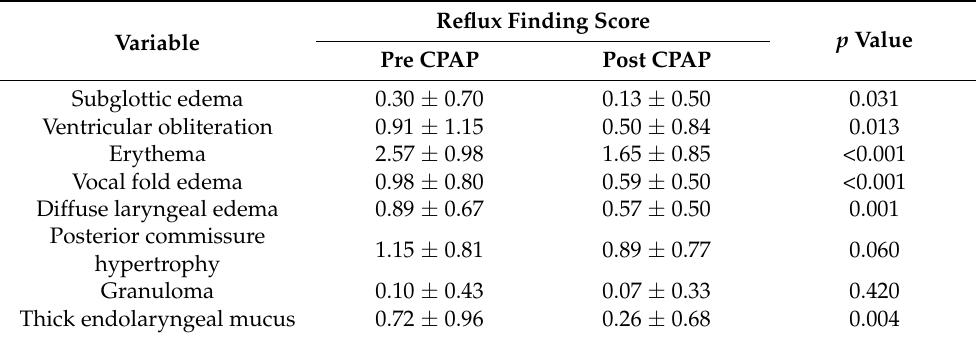
Table 5. Comparison of individual reflux finding score subdomains before and after CPAP treatment.